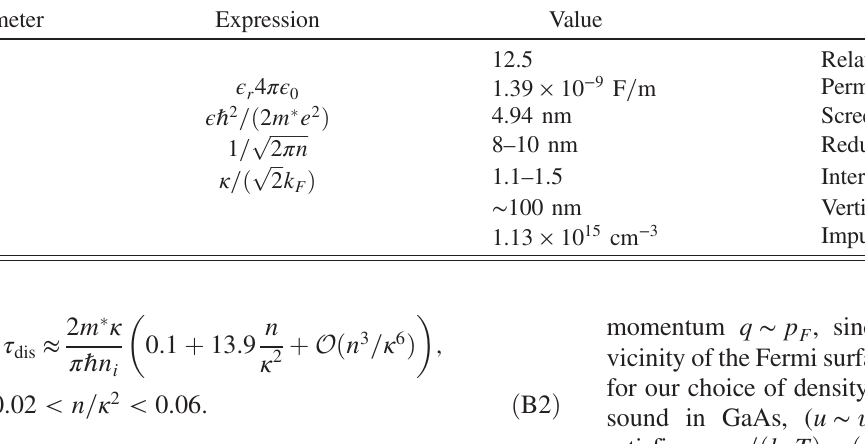
TABLE I. Parameters for the resistivity of 2DEG relevant to impurities. Parameter